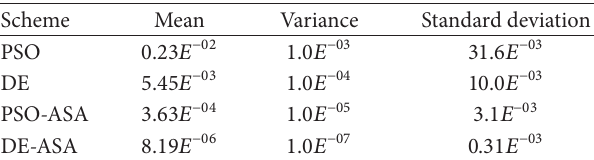
Table 5: Mean, variance, and standard deviation in terms of RMSE for two